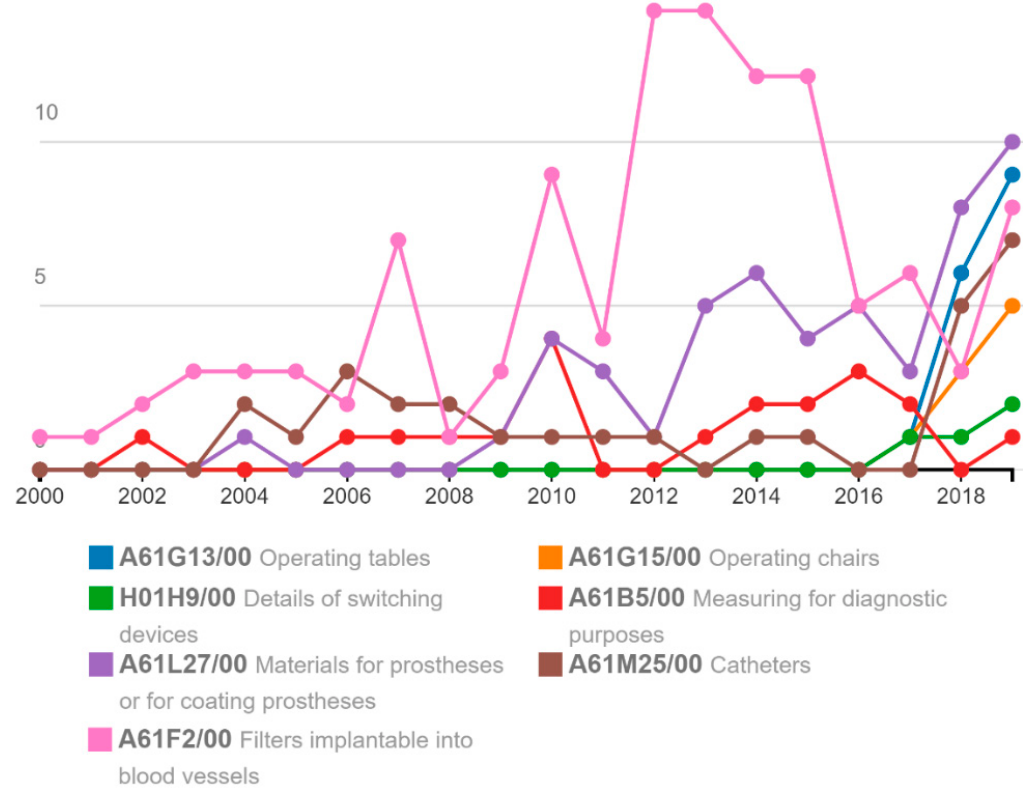
Figure 4. IPC code evolution for patents submitted by applicants from the Czech Republic for medical devices area showing patenting trends from 2000 to 2018.